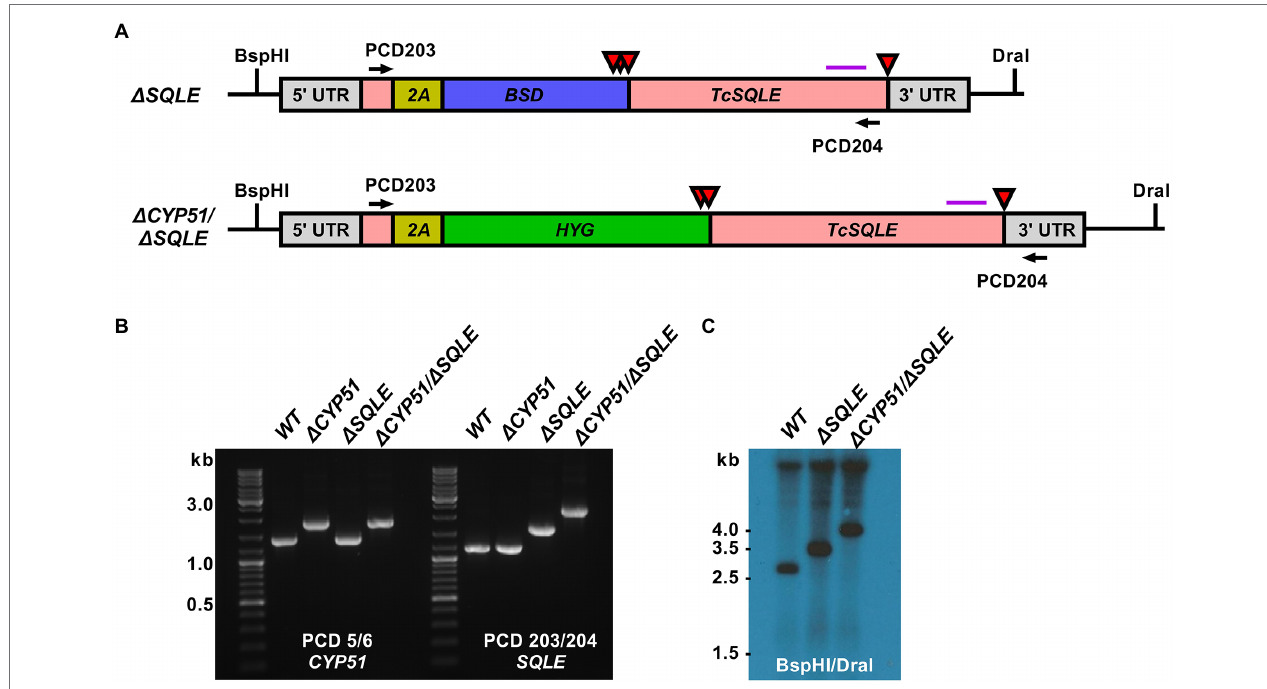
FIGURE 5 | (A) Predicted TcSQLE loci following homology-directed repair template integration shown. The TcSQLE coding region is shown in pink, skip peptide in yellow. Blasticidin-S deaminase (blue) was used in WT parasites while hygromycin B phosphotransferase (green) was used for transfection of Δ CYP51 parasites already carrying the blasticidin-S deaminase gene. Red triangles indicate the positions of stop codons. The purple horizontal line corresponds to the predicted binding location for the Southern blot probe; BspHI and DraI sites in the genome are indicated. (B) Primers flanking TcSQLE were used to amplify the locus and identify clones with increased band size on an agarose gel. (C) Southern blot following digestion of genomic DNA with BspHI/DraI and hybridization with a probe binding to the 3 ′ region of TcSQLE